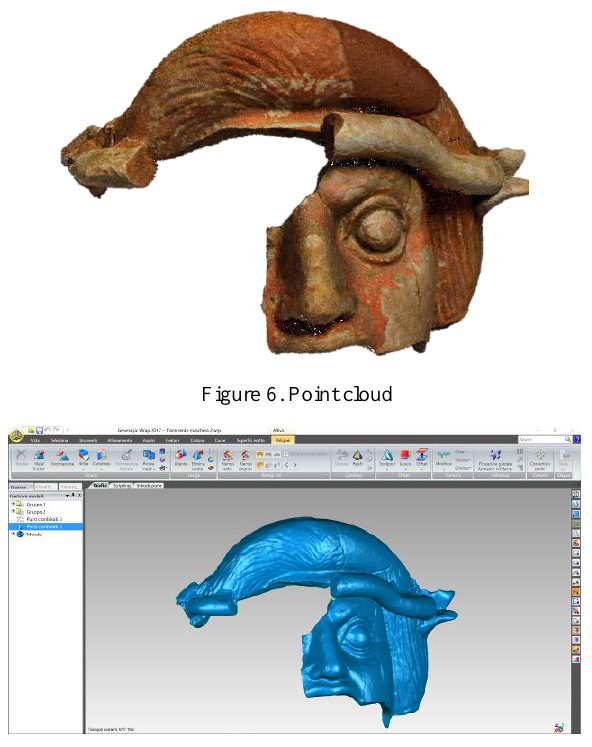
Figure 7. 3D Model Clay